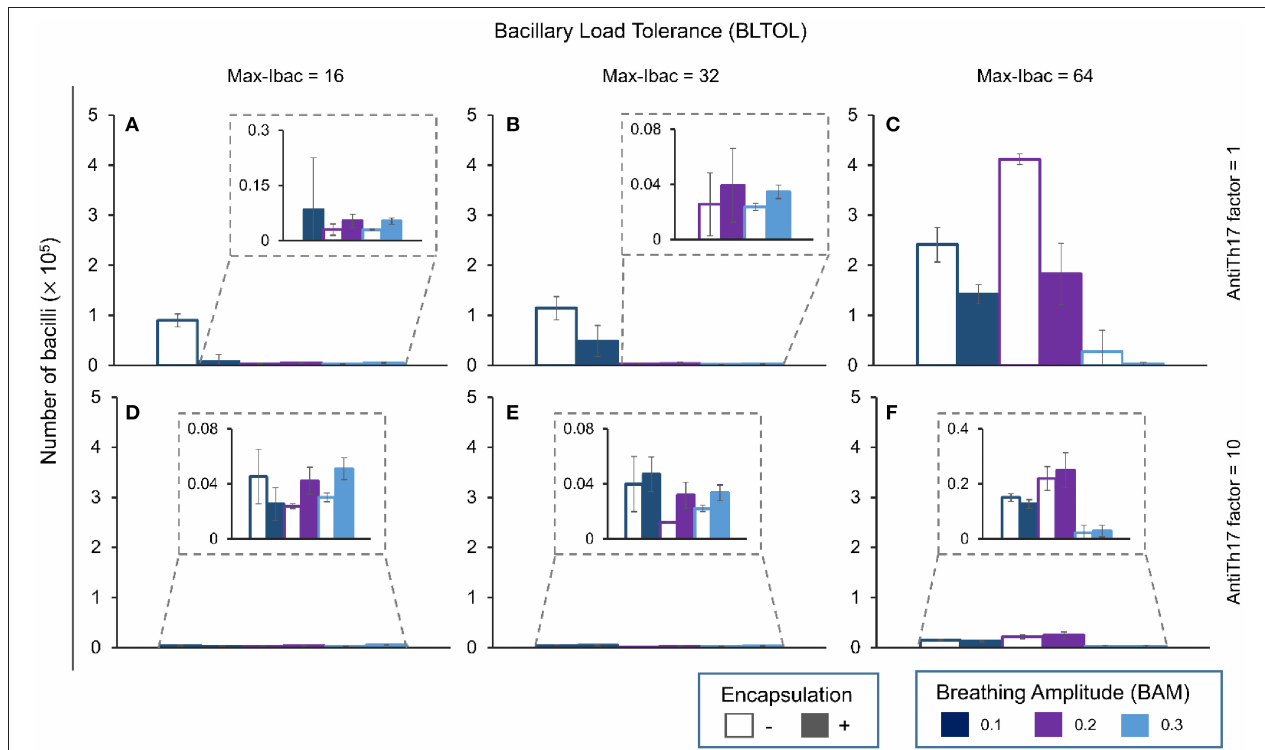
FIGURE 6 | Influence of different parameters on the number of dormant bacilli at day 42. Maximum bacillary load per macrophage (BLTOL): 16 (A,D) , 32 (B,E) , 64 (C,F) . AntiTh17 factor: 1 (A–C) , 10 (D–F) Encapsulation factor: − , no encapsulation, + , encapsulation. Breathing amplitude (BAM): 0.1, 0.2, 0.3. Bars indicate the mean of 10